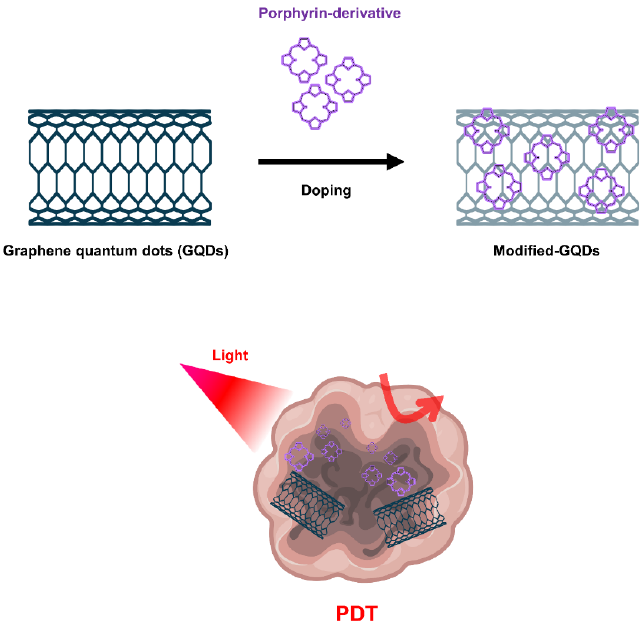
Figure 5. Graphene quantum dots (GQDs)-based nanomaterials for